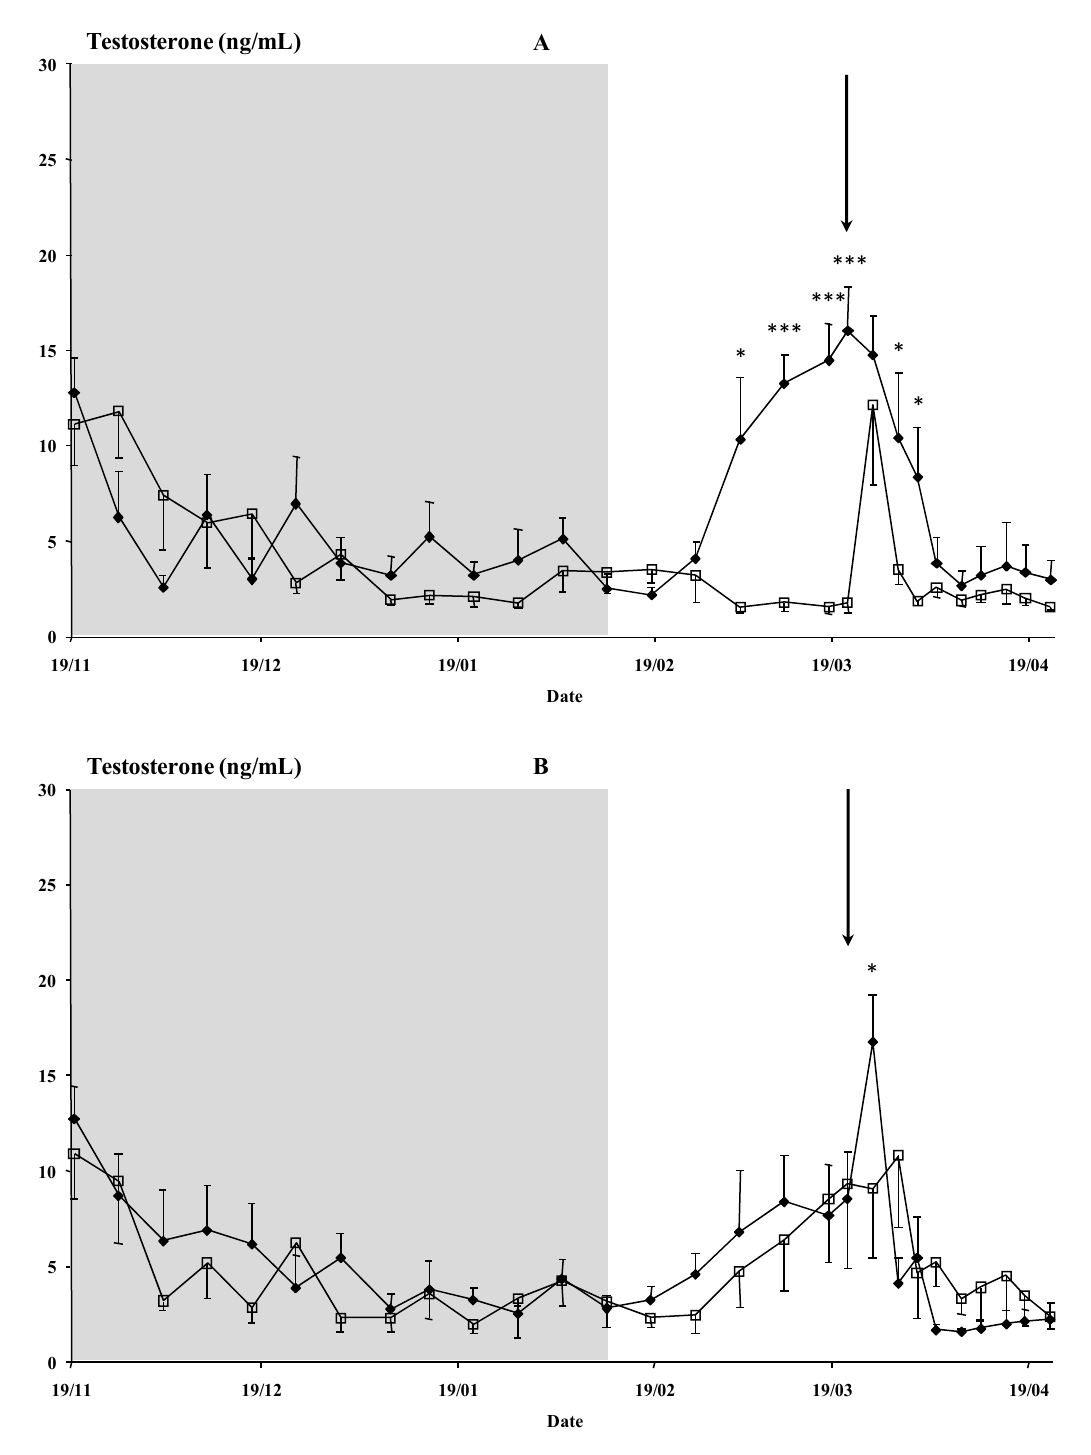
Figure 1. (Experiment 1). ( A ) Plasma testosterone concentrations (ng/mL) of males submitted to a photoperiod treatment, i.e., long days for three months between November and February ( , n = 7) and untreated males ( , n = 7). ( B ) Plasma testosterone concentrations (ng/mL) of males (both photoperiod-treated, i.e., long days for three months between November and February, and un- treated males) used ( , n = 8) or not used ( , n = 6) to induce the male effect. The shaded area in- dicates the photoperiod treatment time. The arrow indicates the moment of the introduction of the bucks.* p < 0.05. *** p < 0.001 in the same day differ significantly between male groups. No differences at any point were observed between the photoperiod-treated bucks (Photo Used vs. Photo Isolated) ( p > 0.05) (Figure 2A). Similar results were found for the